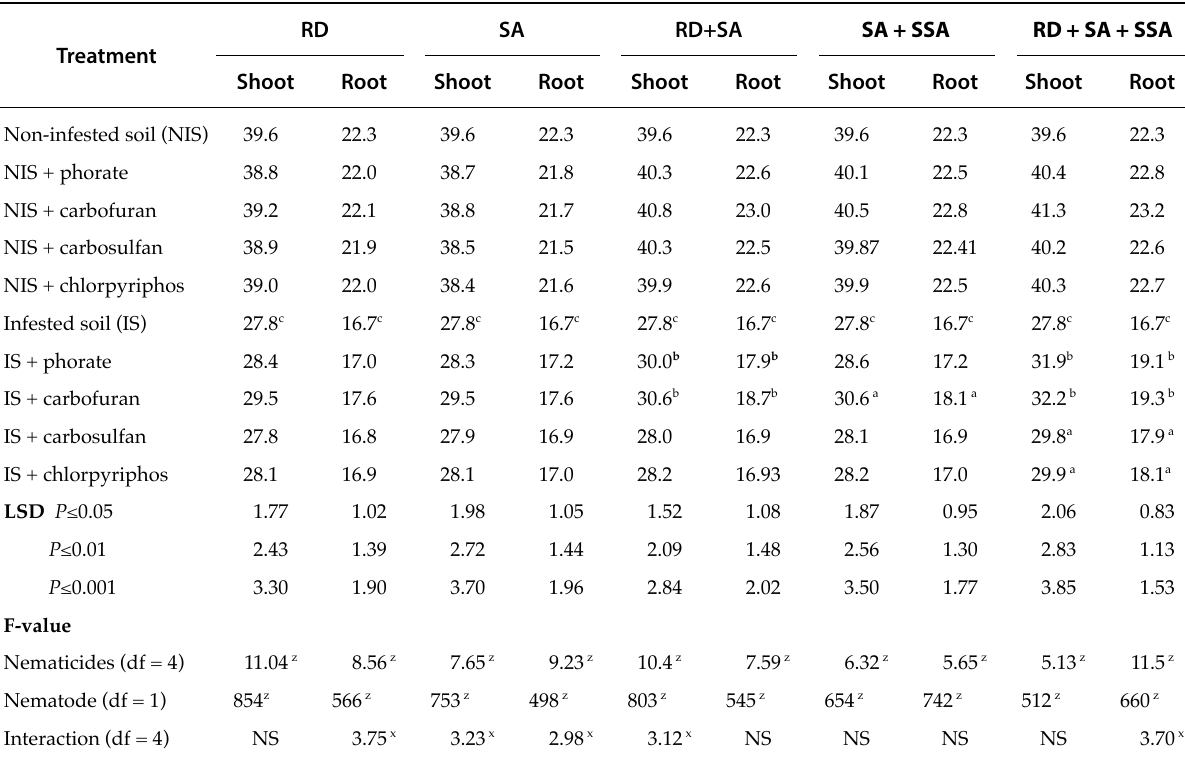
Table 2. Mean shoot and root lengths (cm) of rice plants grown in soil that was either infested or non-infested with Meloido- gyne graminicola and to which different nematicide treatments were applied. RD, root dip; SA, soil application 15 days after transplanting; SSA, second soil application 30 days after transplanting. Each value is mean of ten replicates. RD Treatment Shoot